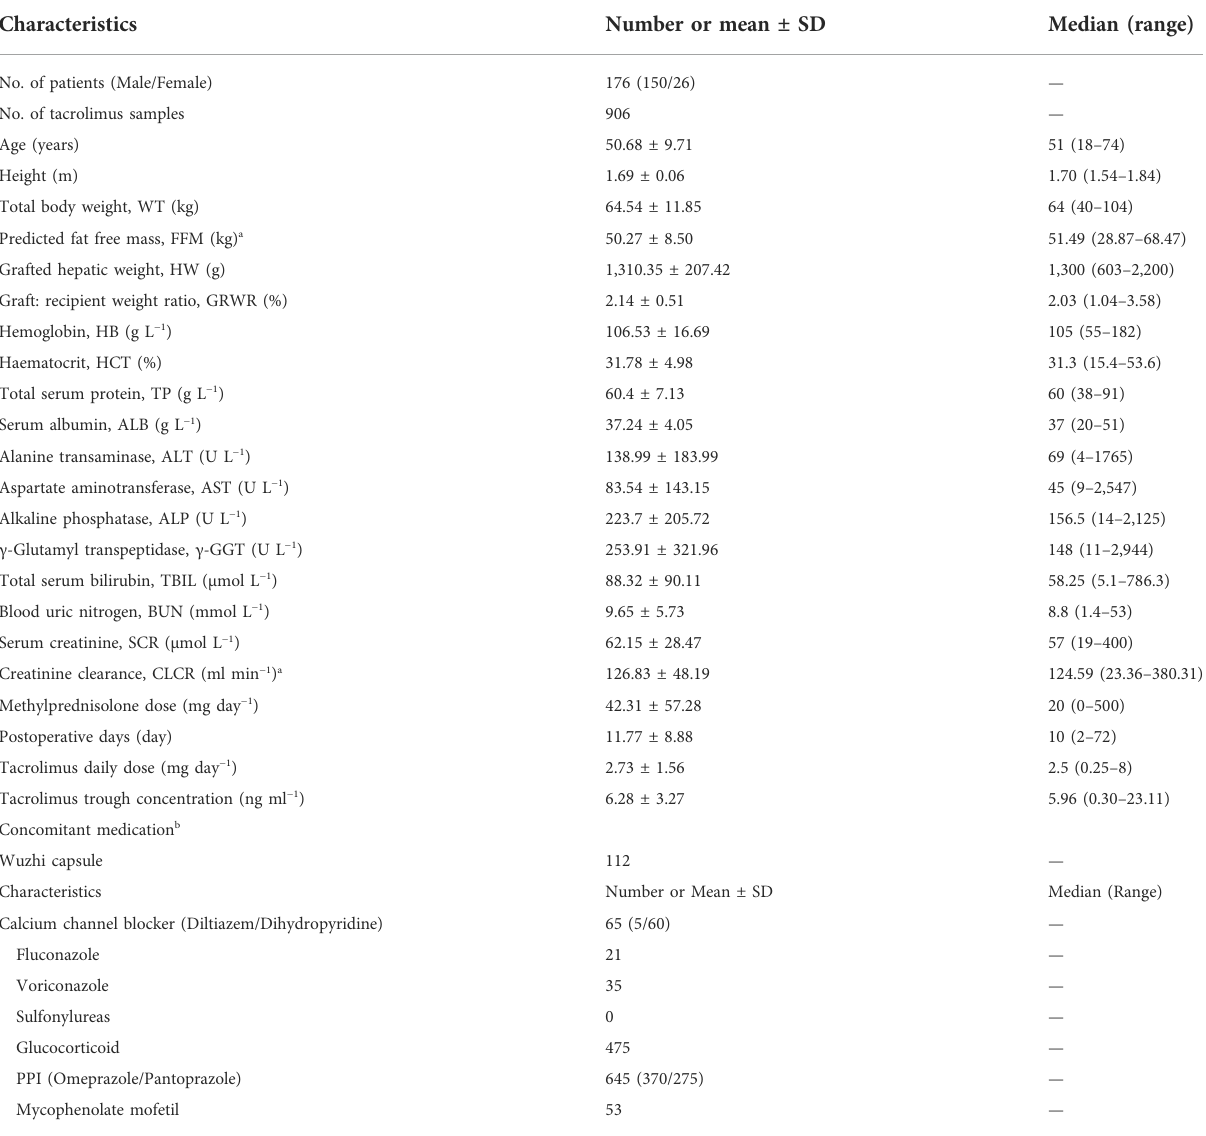
TABLE 1 Demographic and clinical characteristics of participants after liver transplantation used for model